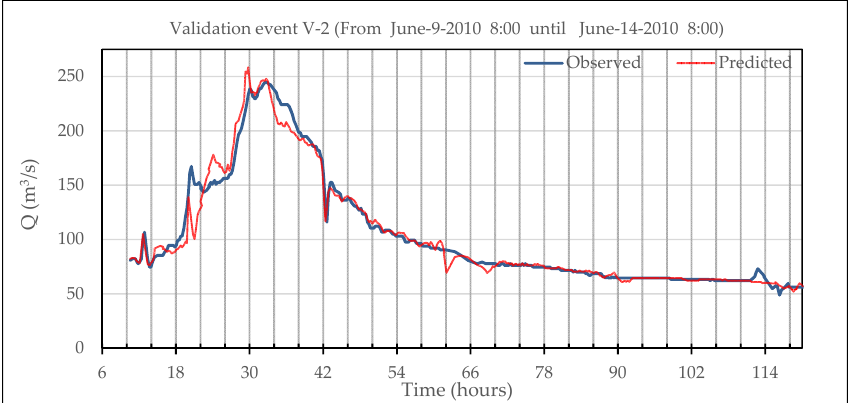
Figure 13. Comparison of 2 h lead time flow forecasts and observed outflows at the Graus station (validation event V3).